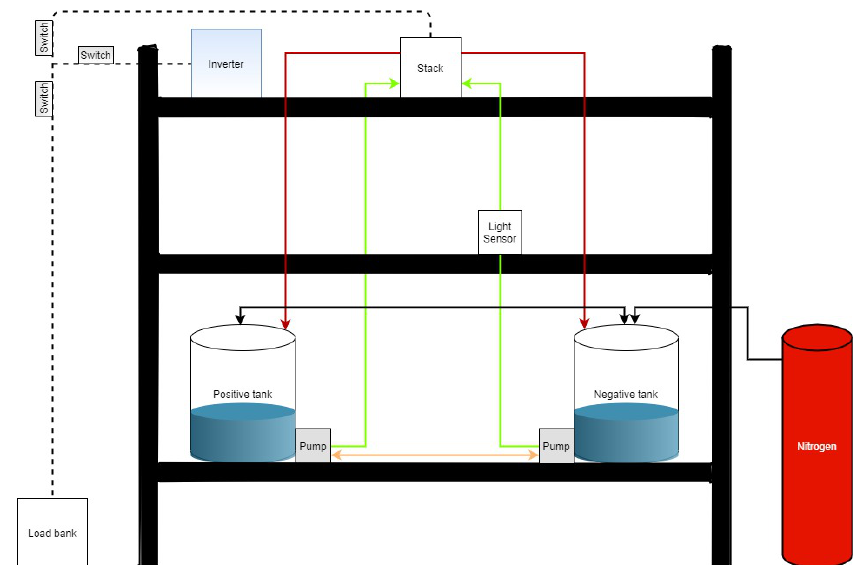
Figure 1. Setup of the VRFB system